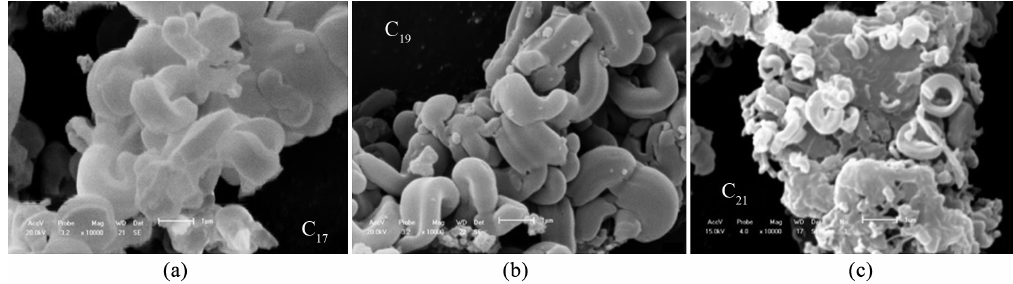
C C samples. 17 19 21